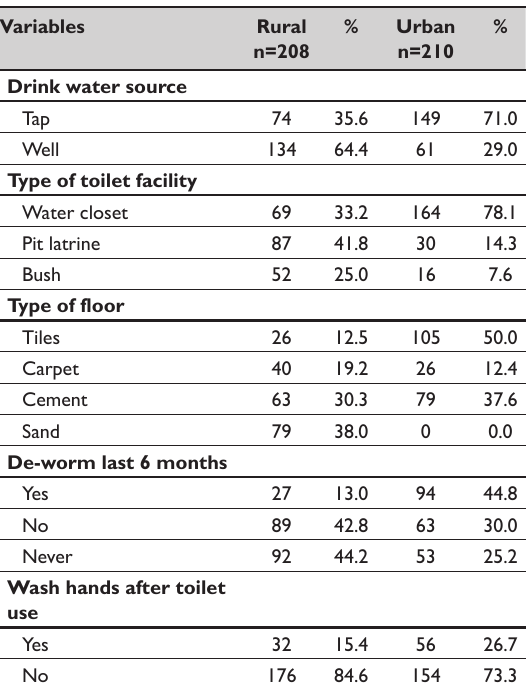
Table 3: Risk factors for intestinal parasitic